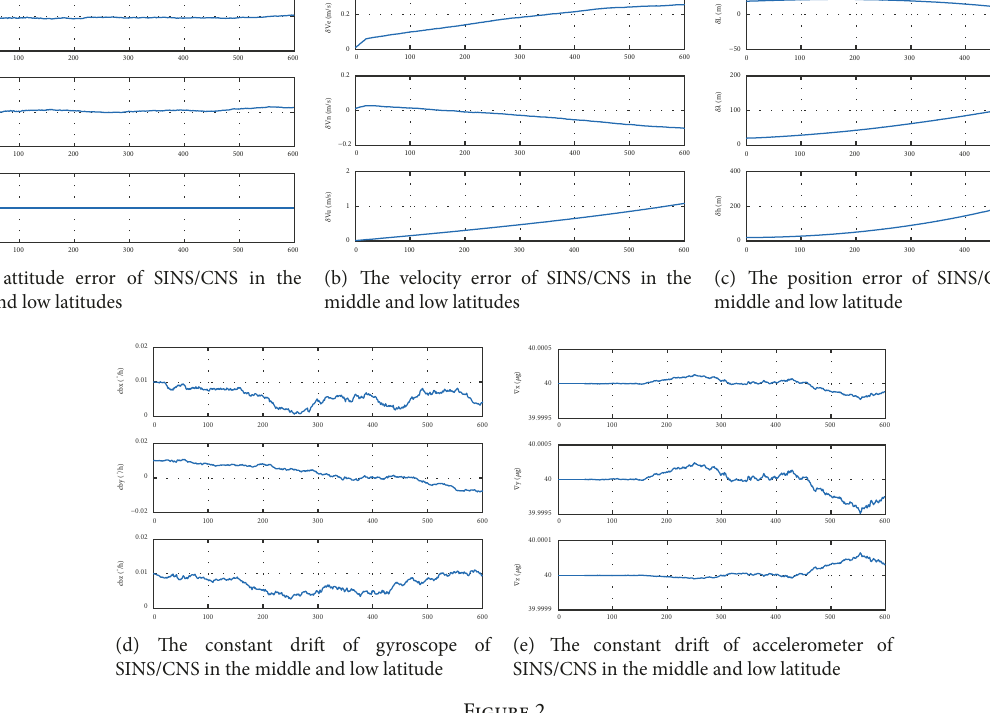
System in the Polar Regions. Because the star sensor optical axis is fixedly connected with aircraft, the state variable contained the installation deviation angle between the SINS and the star sensor. It selects the state variable of SINS/CNS as the misalignment angle of grid eastward, the misalignment